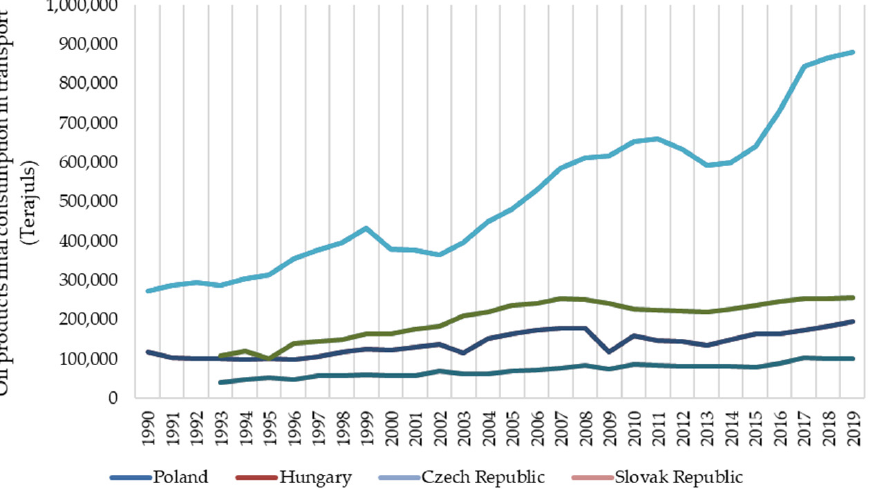
Figure 1. Energy consumption in transport in V4 countries in 1990–2019 (oil products final consumption in transport) in terajoules. Source: OECD database.